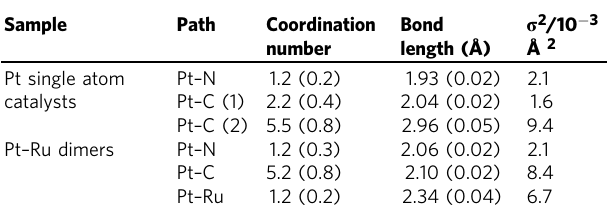
Table 2 R space fi tting results from Pt L 3 edge for Pt